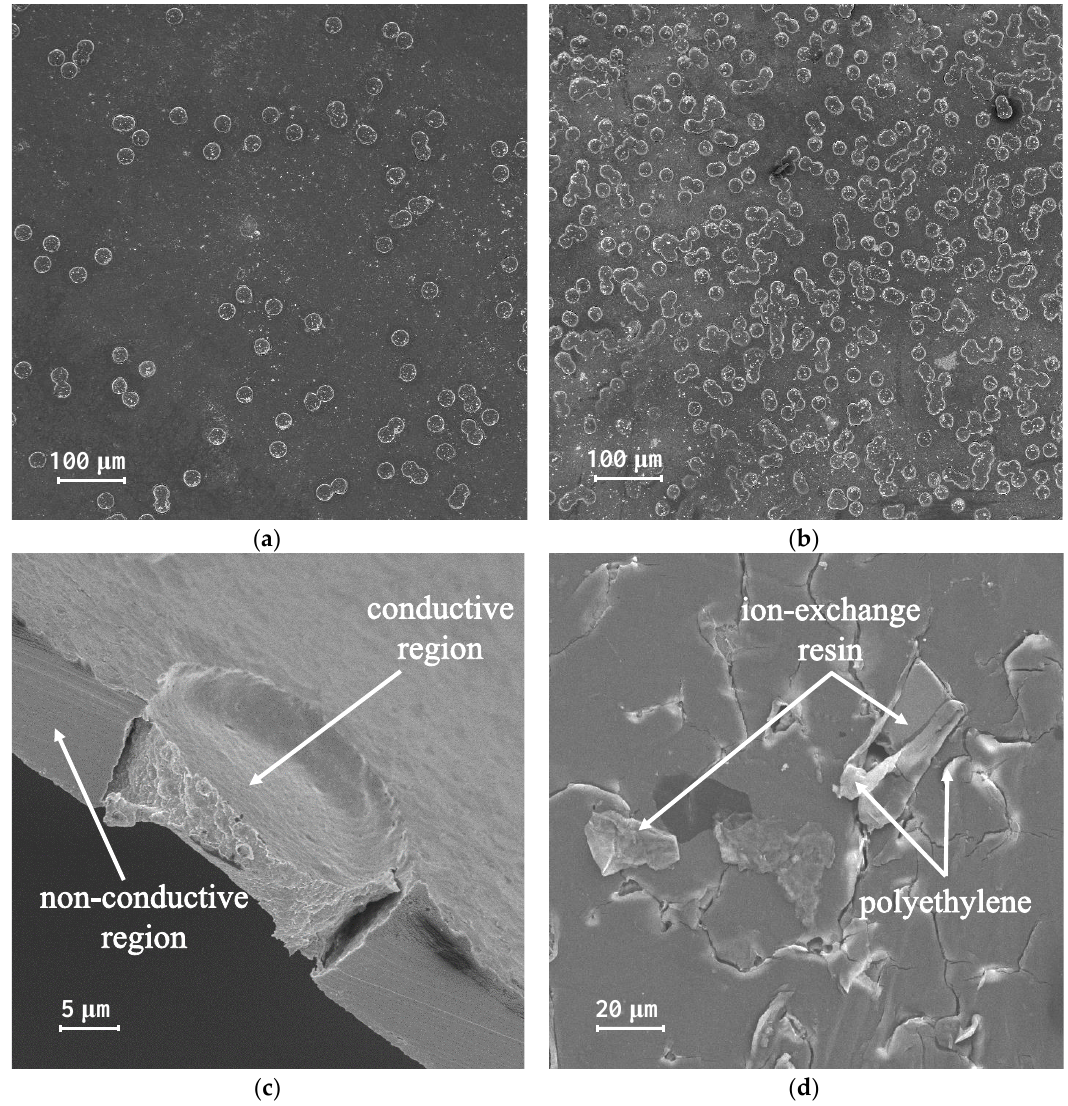
Figure 3. SEM images of the surface of the heterogeneous M1 ( a ) and M2 ( b ) membranes, as well as a cross-section through the conductive region of the membrane M1 ( c ) and the surface of the MK-40 ( d ) membrane.